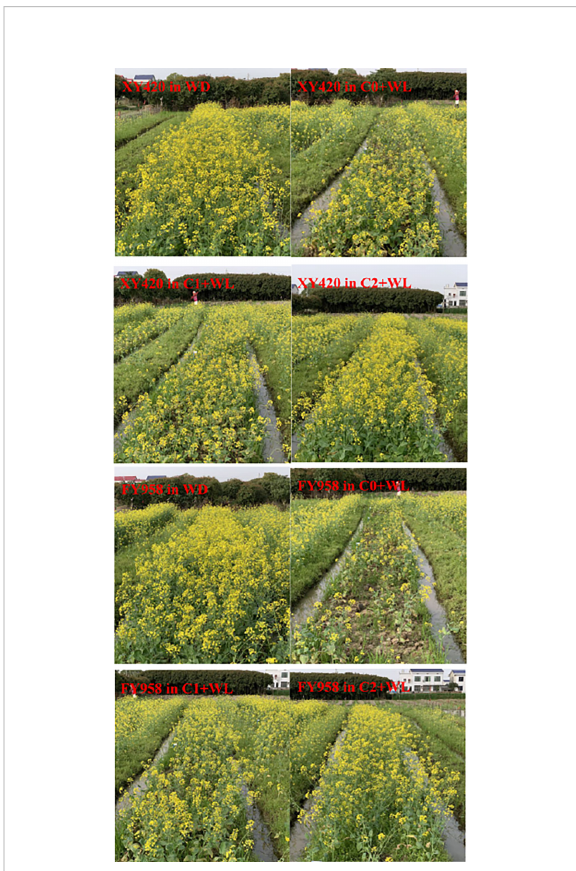
FIGURE 1 Growth phenotype of rape under different treatments at the end of waterlogging. XY420 in WD, well-draining; XY420 in C0+WL, XY420 with no CaO 2 and waterlogging; XY420 in C1+WL, XY420 with 594 kg hm -2 of CaO 2 in the form of base fertilizer and waterlogging; XY420 in C2+WL, XY420 with 864 kg hm -2 of CaO 2 in the form of base fertilizer and waterlogging; FY958 in WD, well-draining; FY958 in C0+WL, FY958 with no CaO 2 and waterlogging; FY958 in C1+WL, FY958 with 594 kg hm -2 of CaO 2 in the form of base fertilizer and waterlogging; FY958 in C2+WL, FY958 with 864 kg hm -2 of CaO 2 in the form of base fertilizer and